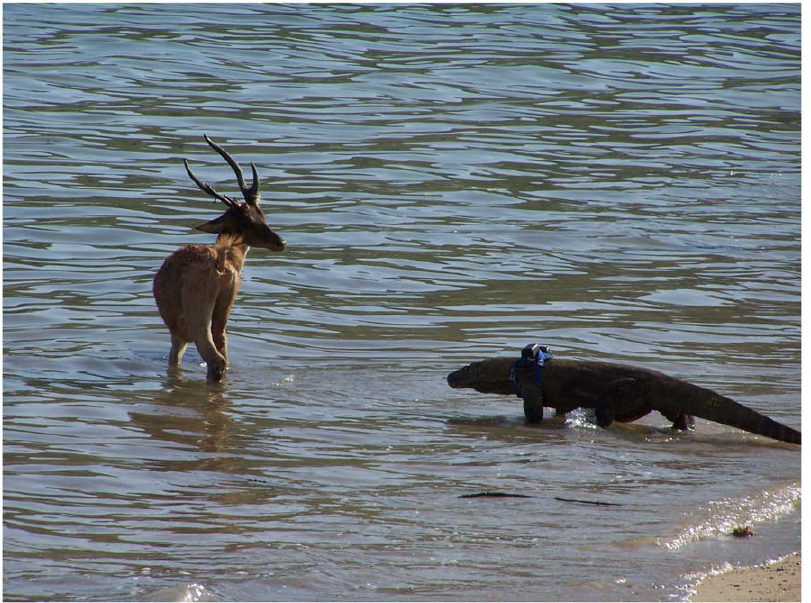
Figure 1. Pursuit of an escaped prey by a second dragon. An injured Timor deer that has escaped an initial lizard has fled to the ocean and is being stalked by a different dragon. This second lizard succeeded in killing the deer. The Komodo dragon pictured is wearing a GPS collar used for tracking the animal. Occasional prey escape is essential to the operation of the lizard-lizard epidemic model. (Photo by Achmad Ariefiandy.)